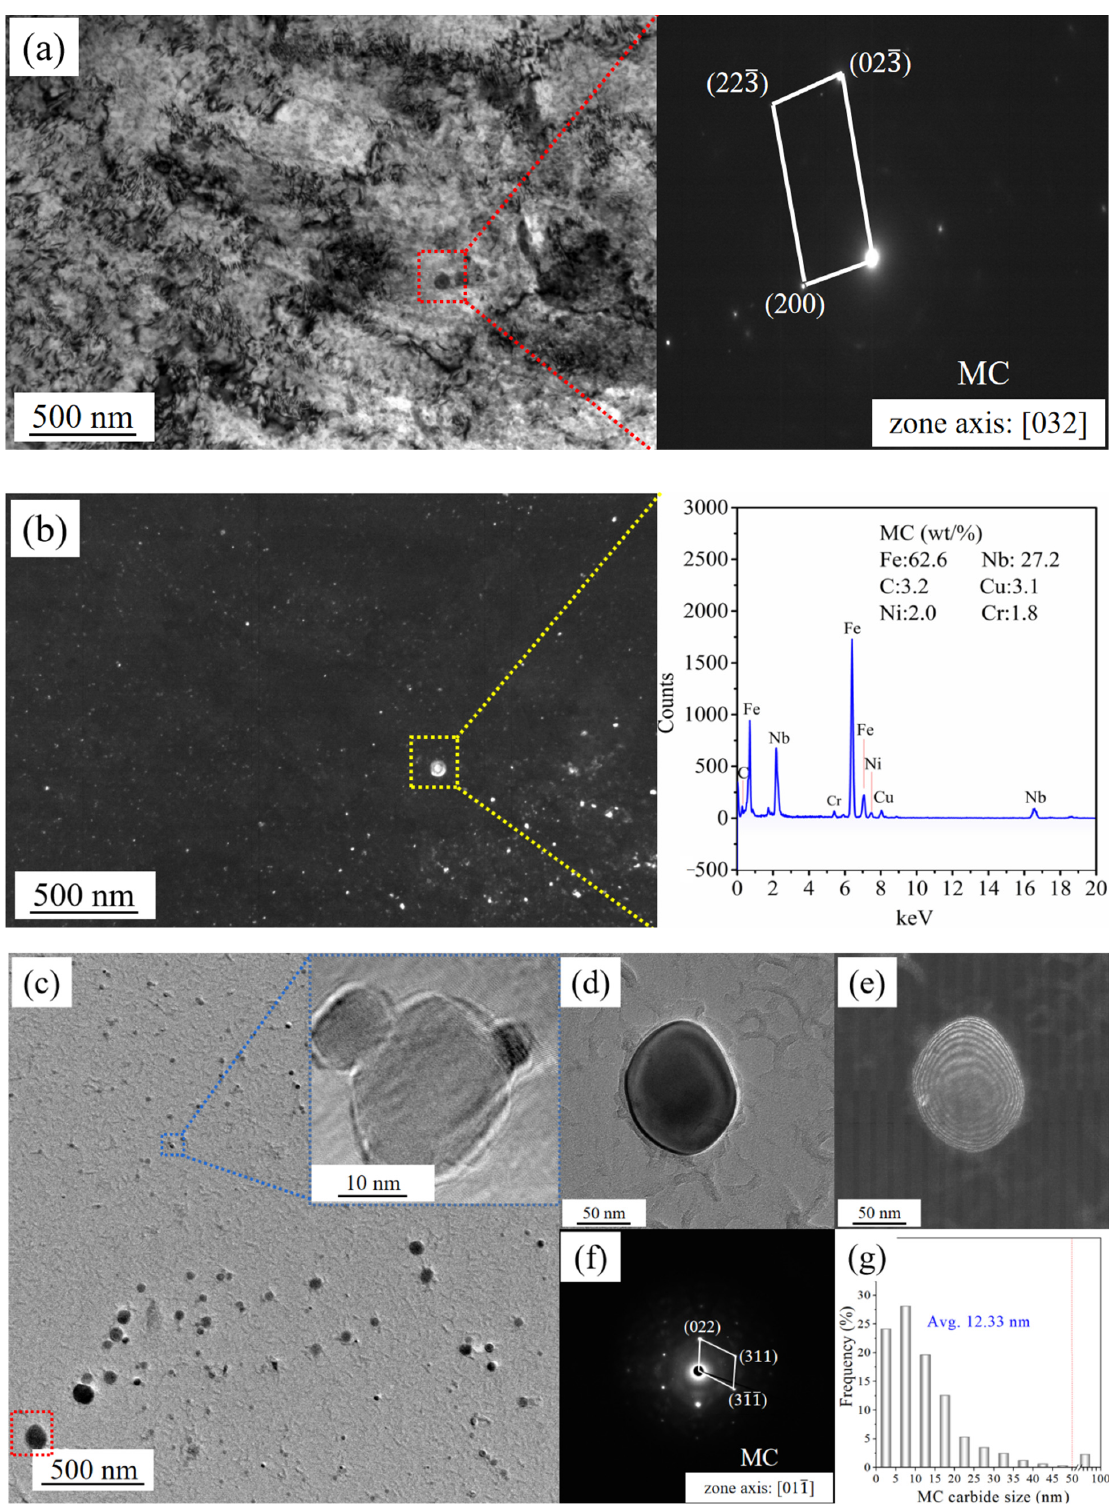
Figure 9. ( a , b ) TEM and dark field micrographs show the existence of nano-sized MC carbides after tempering. Inserted graphs in ( a ) and ( b ) show diffraction pattern and EDS spectrum of selected area, respectively. ( c ) TEM images of MC carbide prepared via the carbon extraction replica method. Inserted graph shows HRTEM image of selected area. ( d – f ) TEM, dark field micrographs and SAED pattern of MC carbide selected in the dotted box in ( c ). ( g ) The distribution curves of the size of MC carbides.